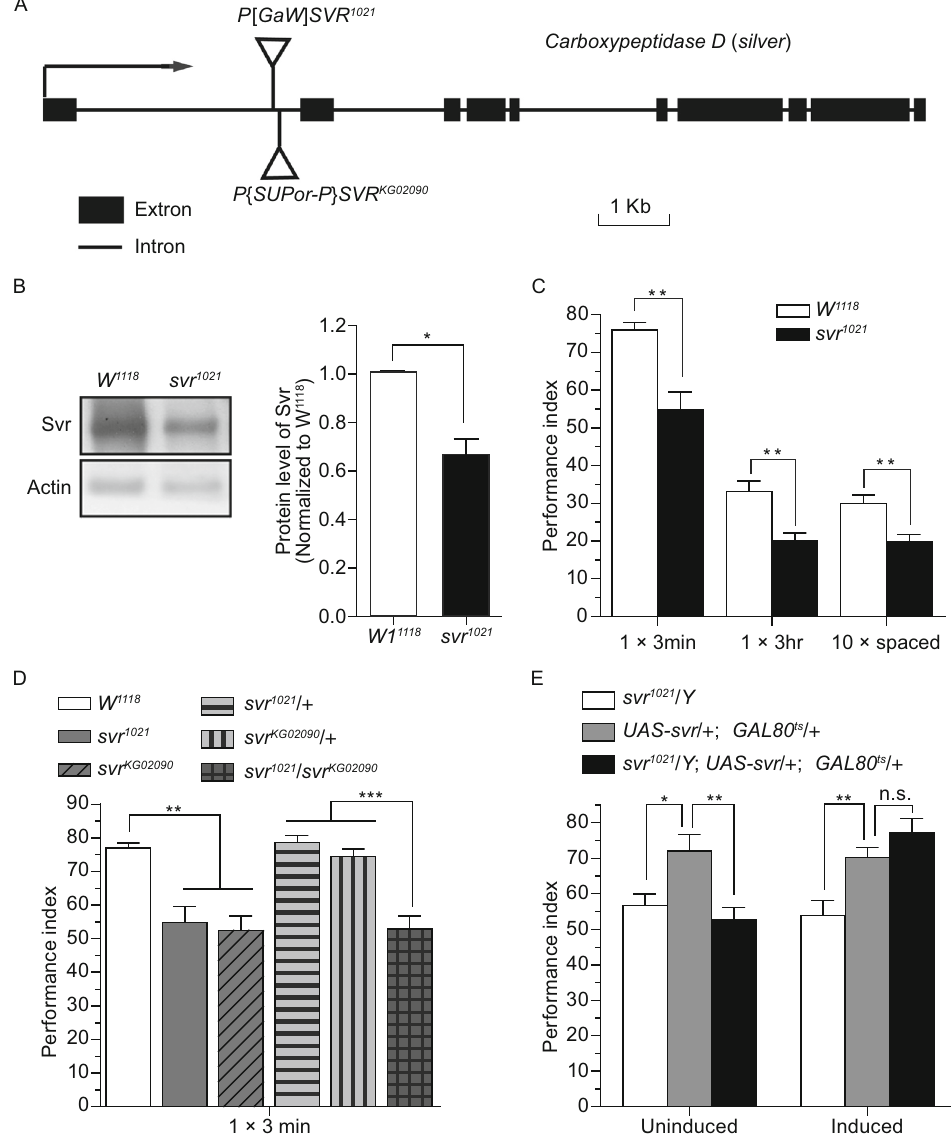
Figure 1. The memory formation of svr 1021 mutant is impaired and acute expression of svr + transgene in the svr 1021 mutant can rescue the impairment . (A) P element insertion sites of the svr gene in svr 1021 and svr KG02090 alleles. Boxes indicate exons and the lines represent introns. (B) Western blot analysis showed that Svr expression was greatly reduced in svr 1021 mutant ( t -test, P < 0.05). n = 3 (C). Memory retention at 3 min and 3 h after one-cycle training and 24 h memory after spaced training were signi fi cantly decreased in svr 1021 mutant ( t -test, P = 0.001, 0.004, 0.005 compared to w 1118 for 3 min, 3 h, 24 h after spaced training, respectively). n = 6 – 8. (D) Genetic complementation analysis established that disruption the svr gene was responsible for the memory defect. The 3-min memory in double-heterozygote ( svr 1021 / svr KG02090 ) was signi fi cantly lower than the other two heterozygous fl ies ( svr 1021 /+ or svr KG02090 /+) or the control fl ies (ANOVA, P < 0.001). n = 6 – 8. (E) The 3-min memory defect in svr mutant was reversed by